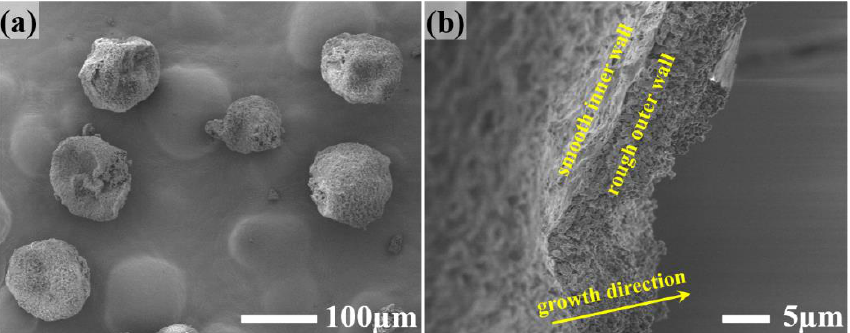
Figure 4. SEM images of the synthesized polyamine microcapsules ( a ) and the corresponding cross-section ( b ) when 9.0 g HMDI was adopted in the reaction solution.